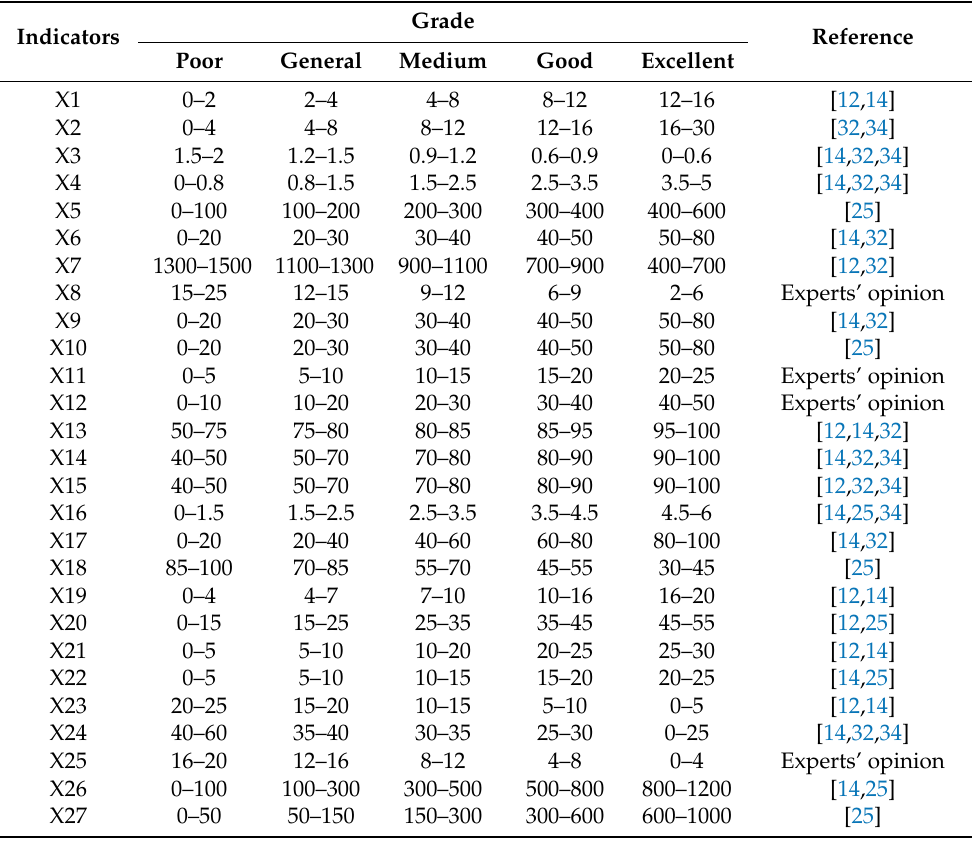
Table 3. The classical domain and joint domain of